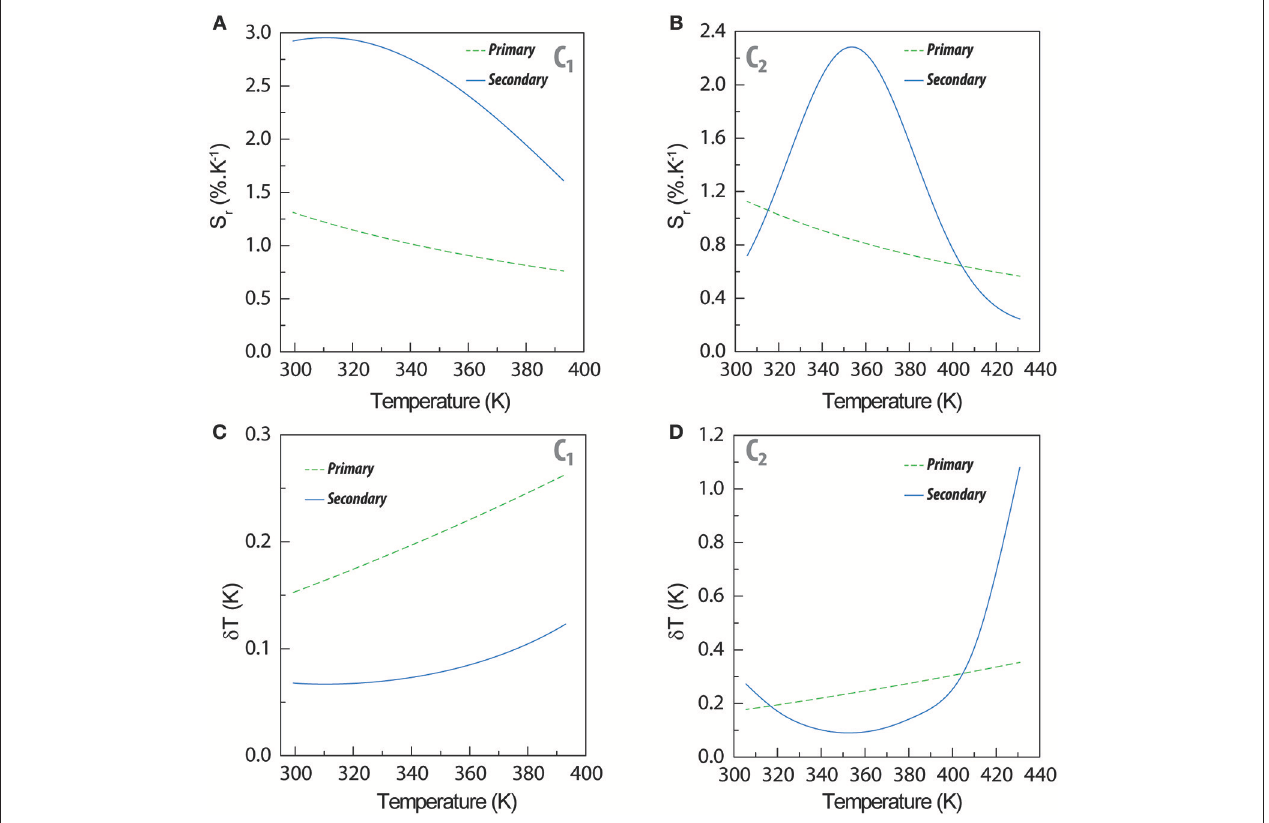
FIGURE 4 | Temperature measured by a thermocouple in contact with the composite films ( x ) vs. the temperature calculated using Equation 2 ( T p , y ) for (A) C 1 and (B) C 2 . Calculated temperature T p ( x ) vs. calculated temperature T s ( y ) using the calibration curve of the Er 3 + /Tm 3 + secondary thermometer ( T s , y) for (B) C 1 and (D) C 2 . In ( B , D) , the open and solid symbols correspond to the calibration points and validity checks, respectively, as detailed in Experimental section. The straight lines correspond to y = x in all the